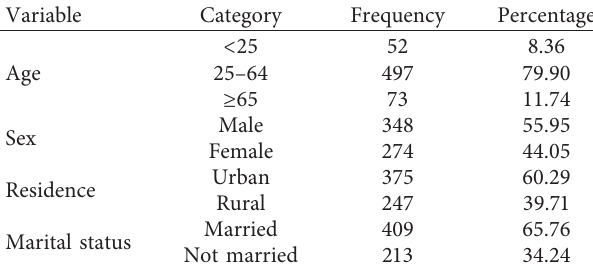
Table 1: Sociodemographic characteristics of COVID-19 patients admitted to Amhara region COVID-19 treatment centers, 2021 ( n �